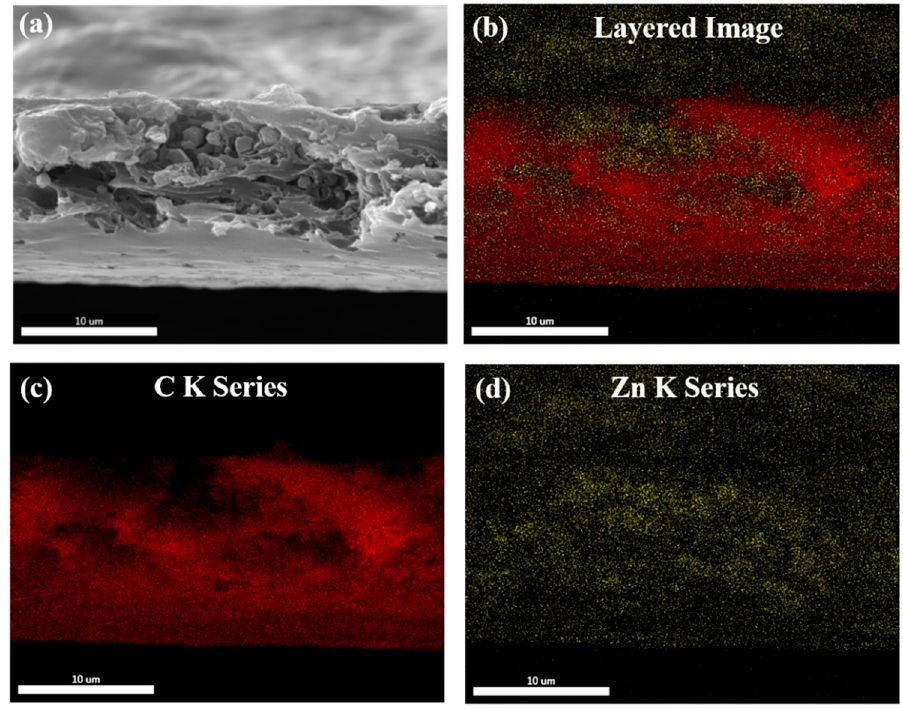
Figure 8. Energy-dispersive X-ray spectroscopy (EDS) of the 20 wt% MMM: ( a ) SEM Image; ( b ) EDS Mapping; ( c ) C K α ( d ) Zn K α .